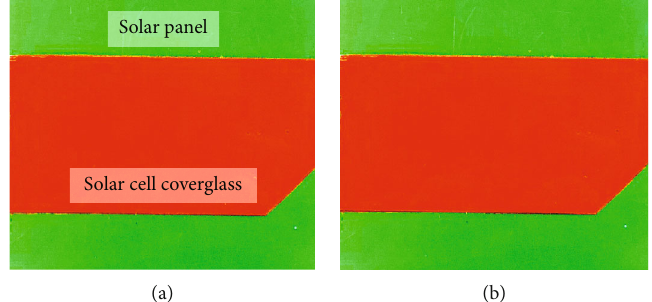
Figure 17: Visual inspection test results of the solar cell coverglass: (a) before TV environment test and (b) after TV environment test. Table 6: Summary of release time and structural safety results of the solar panel module at each event. Test